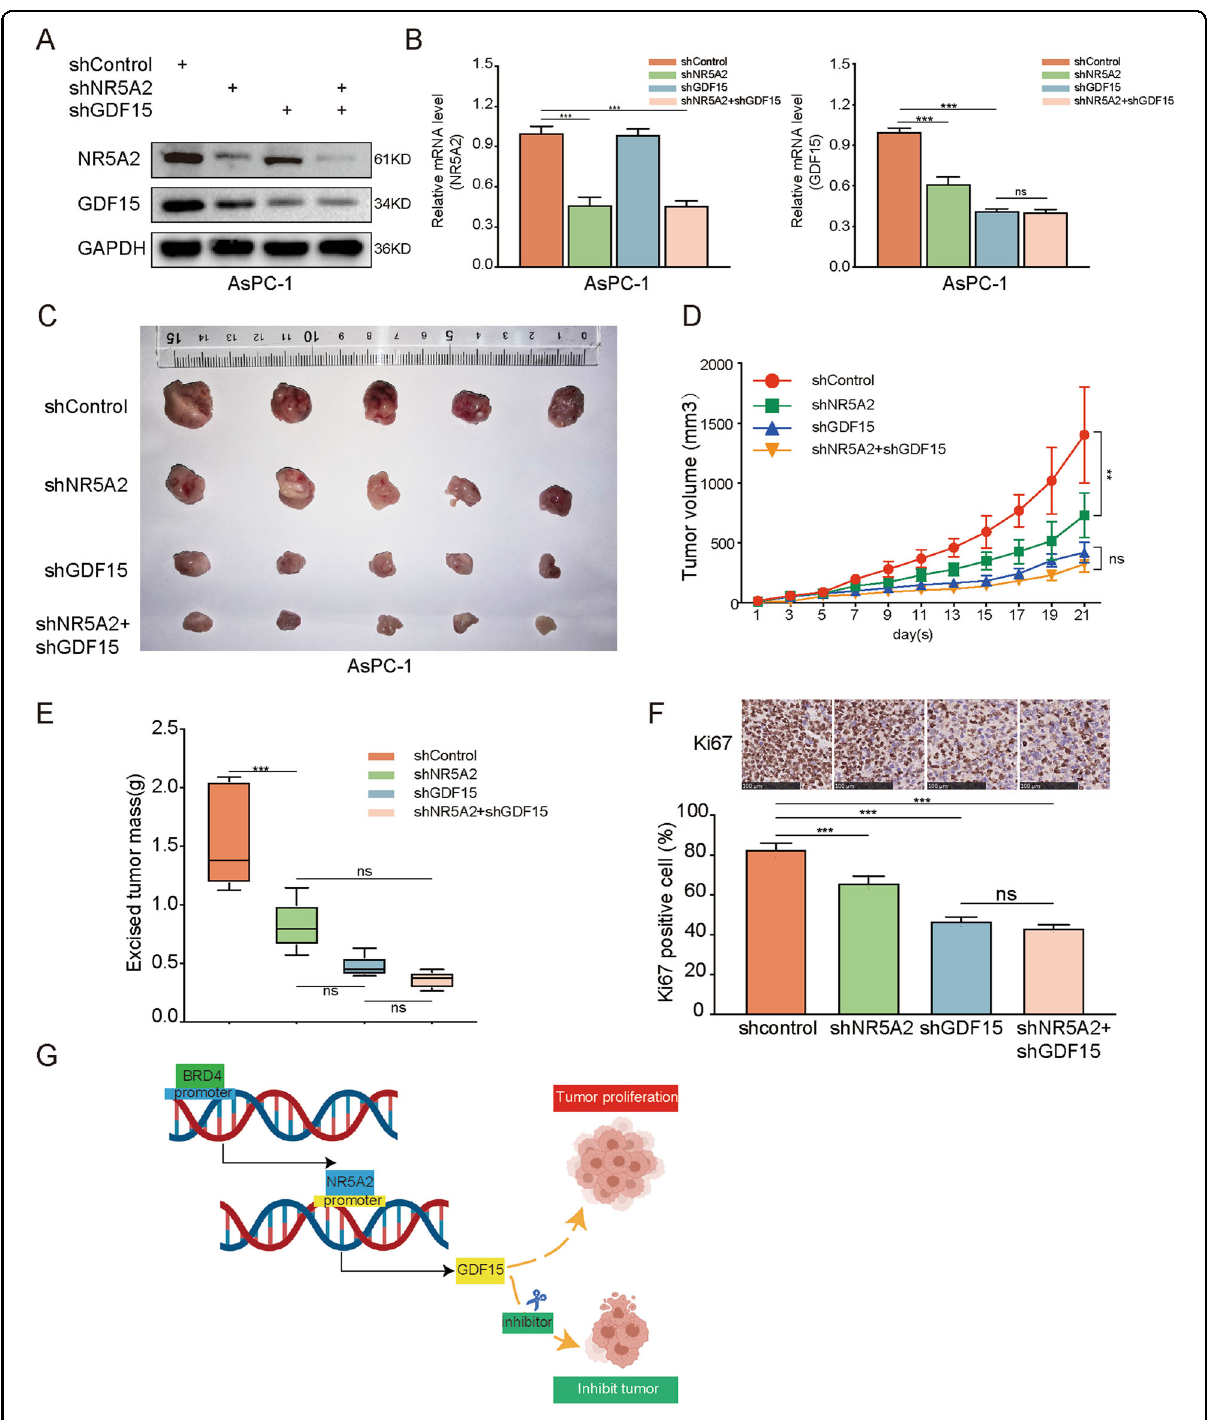
Fig. 8 NR5A2 silencing inhibited tumor growth by downregulating GDF15 expression in vivo. A , B Western blot analysis ( A ) and RT-qPCR ( B ) to show the NR5A2 and GDF15 expression in AsPC-1 and HPAC cells infected with shControl, shNR5A2, shGDF15, or shNR5A2 + shGDF15. GAPDH served as an internal reference. Each bar represents the mean±SD of three independent experiments. *** p <0.001, one-way ANOVA. C – E AsPC-1 cells infected with shControl, shNR5A2, shGDF15, or shNR5A2 + shGDF15 were subcutaneously injected into nude mice. The tumors were harvested and photographed ( C ) on day 21. Data on tumor volume ( D ) and tumor mass ( E ) were shown as means±SD ( n = 5). Statistical analyses were performed with one-way ANOVA. ns not signi fi cant; *** p <0.001. F IHC analysis for Ki-67 expression was performed in tumors harvested from xenografts, and percent of the Ki-67-positive cells were quanti fi ed, the scale bars were shown in the fi gure. All data were shown as mean±SD ( n = 5). ns not signi fi cant; ** p <0.01, one-way ANOVA. G The schematic diagram of this study: NR5A2 transcriptional activation by BRD4 promotes pancreatic cancer progression by upregulating